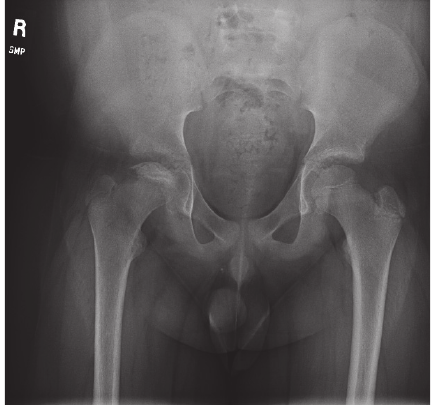
Figure3:APpelvisX-rayobtained6weeksfrominitialpresentation which shows early femoral head